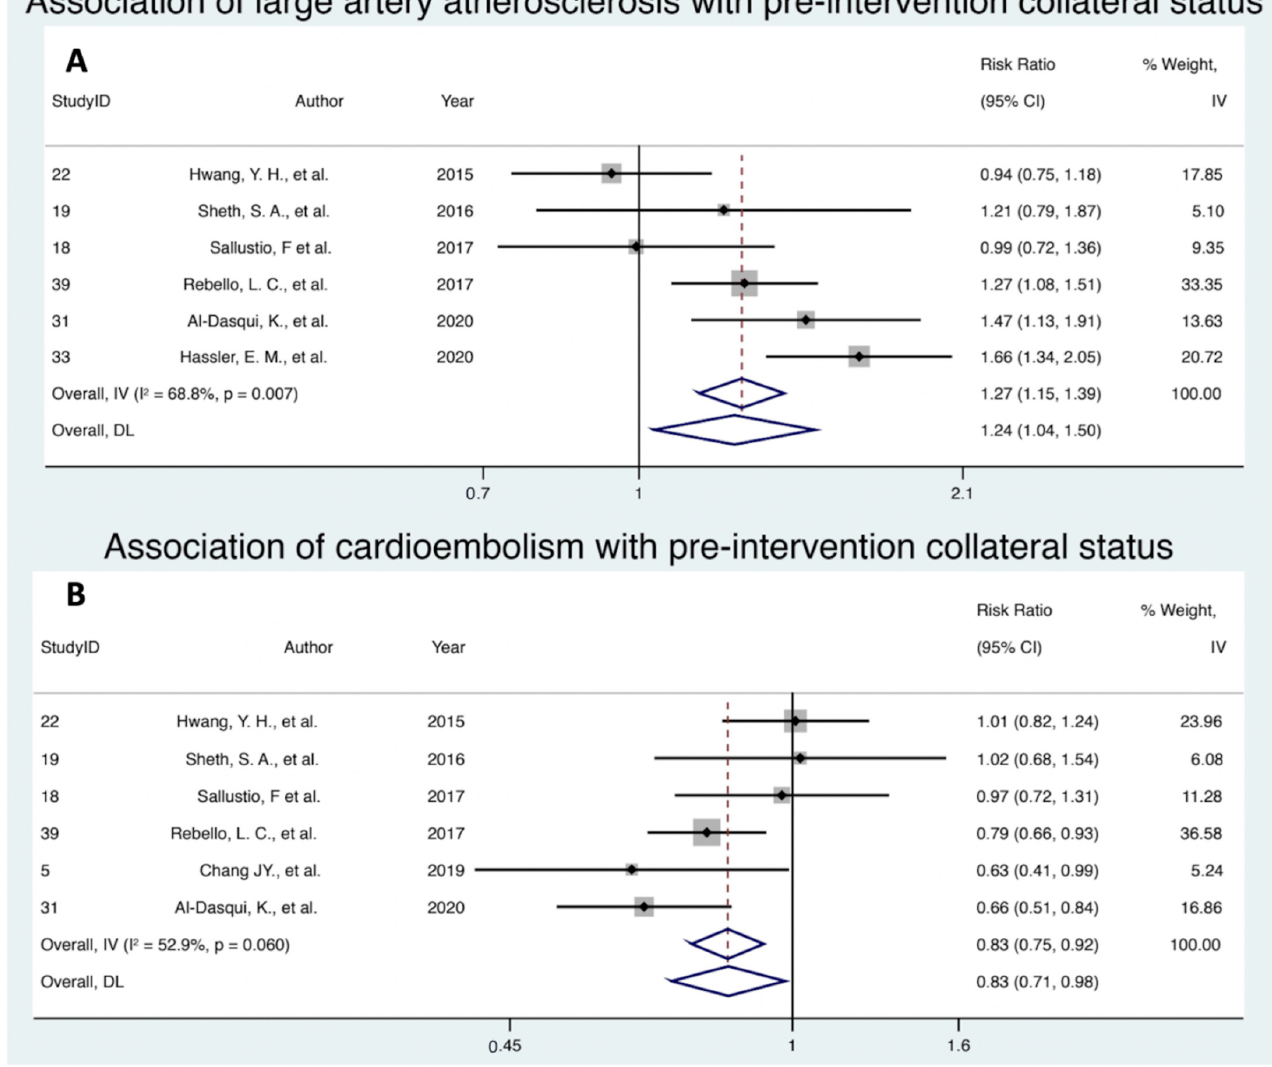
Figure 2. Forest plot showing the association of ( A ) large artery atherosclerosis stroke aetiology and ( B ) cardioembolism stroke aetiology with the pre-intervention collateral status in acute ischemic stroke patients receiving reperfusion therapy. Note: Random effect modelling (DL) values were used. Abbreviations: CI, confidence interval; IV, inverse variance; DL, DerSimonian and Laird.